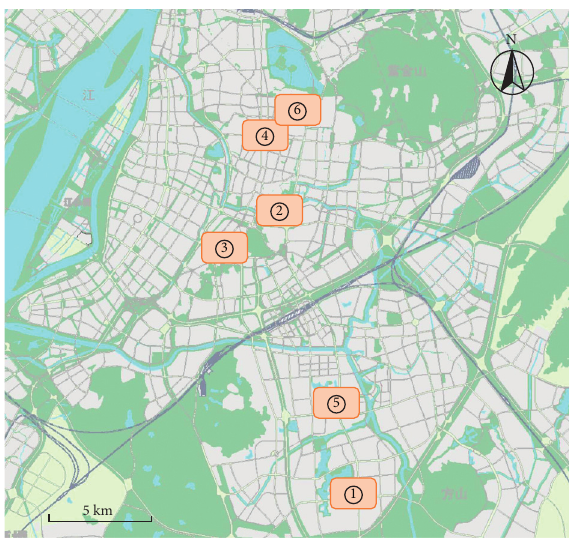
Figure 2: Locations of survey sites. Table 3: Timetable of each survey site.